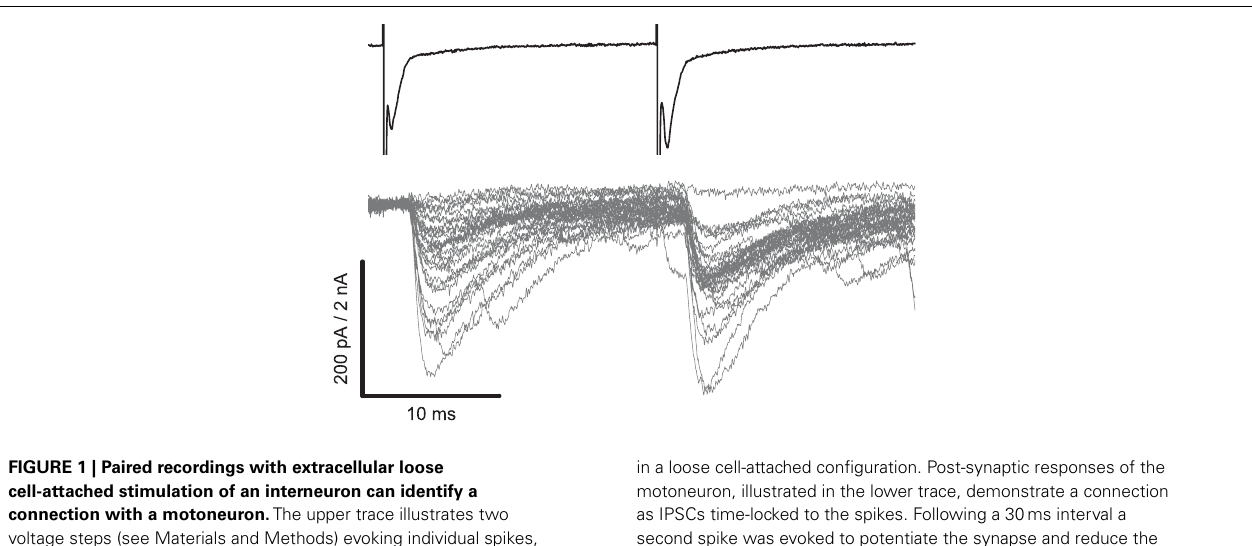
FIGURE 1 | Paired recordings with extracellular loose cell-attached stimulation of an interneuron can identify a connection with a motoneuron. The upper trace illustrates two voltage steps (see Materials and Methods) evoking individual spikes, clearly visible as downward deflections, from an interneuron patched